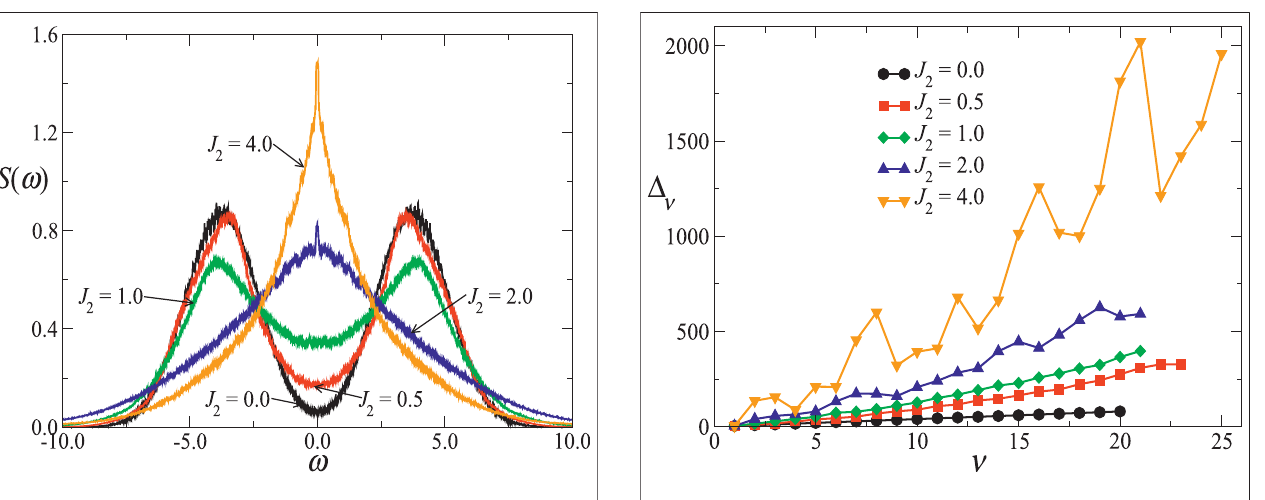
FIGURE 9 | Recurrants of the in fi nite transverse ANNNI model with B (cid:2) 1 . 0 and several values of J 2